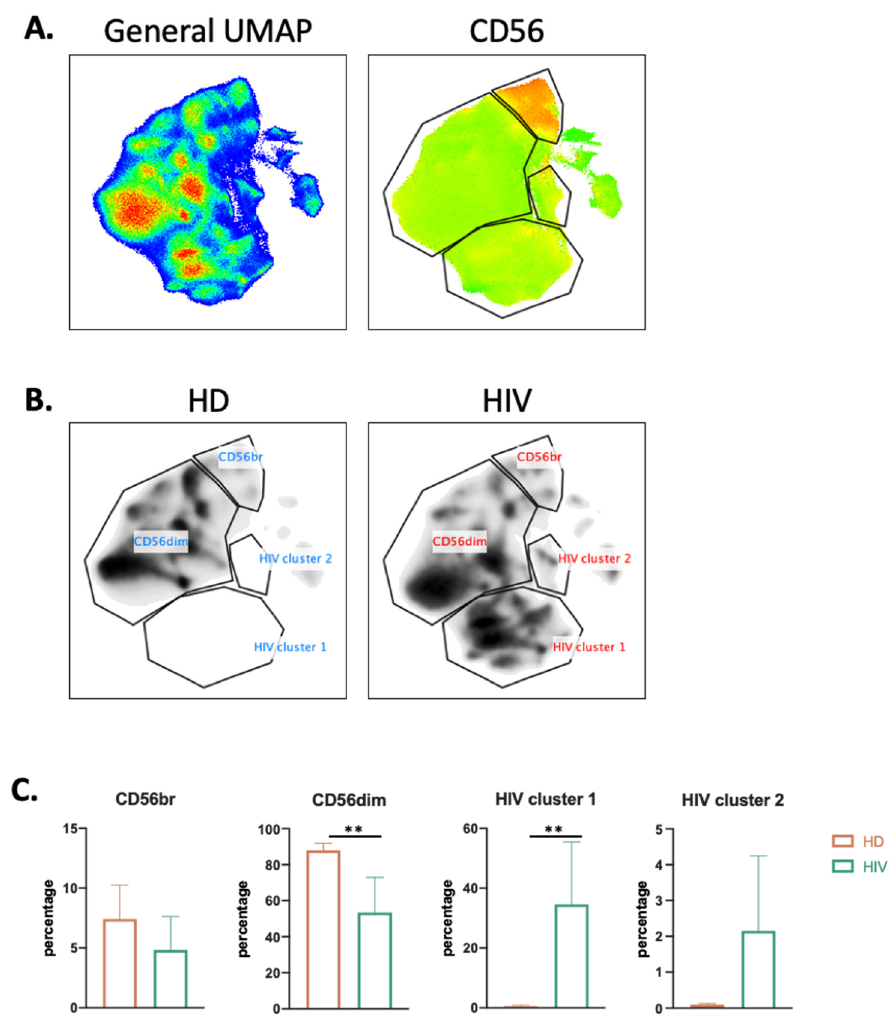
Figure 3. UMAP analysis of second cohort of HIV-1 + patients. ( A ) UMAP plot was generated from 40,000 pre-gated NK cells (CD14-CD19-CD3-CD56 + phenotype) from a cohort of HIV-1 patients ( n = 11) and HD ( n = 4), in the right CD56 heatmap of CD56 expression on different populations. ( B ) UMAP specific of HD and HIV-1+ patients. ( C ) Proportion of each cluster among HD ( n = 4) and HIV-1 patients ( n = 11). Statistical significance was determined by unpaired t -test; ** p ≤ 0.01. Both of these clusters expressed high levels of CD16 and KIRs and also